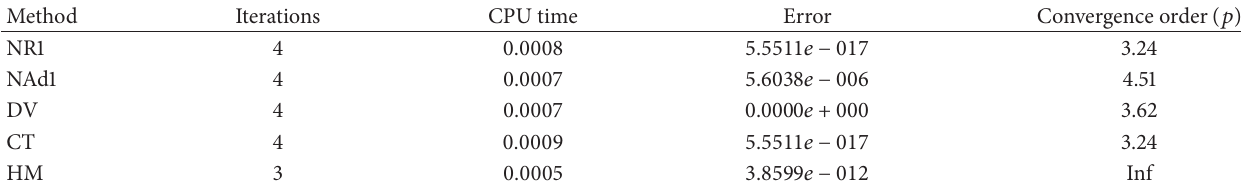
Table 3: Numerical results of Example 3 with initial value 𝑥 0 = (0.5,0.5, 0.5) 𝑇 .